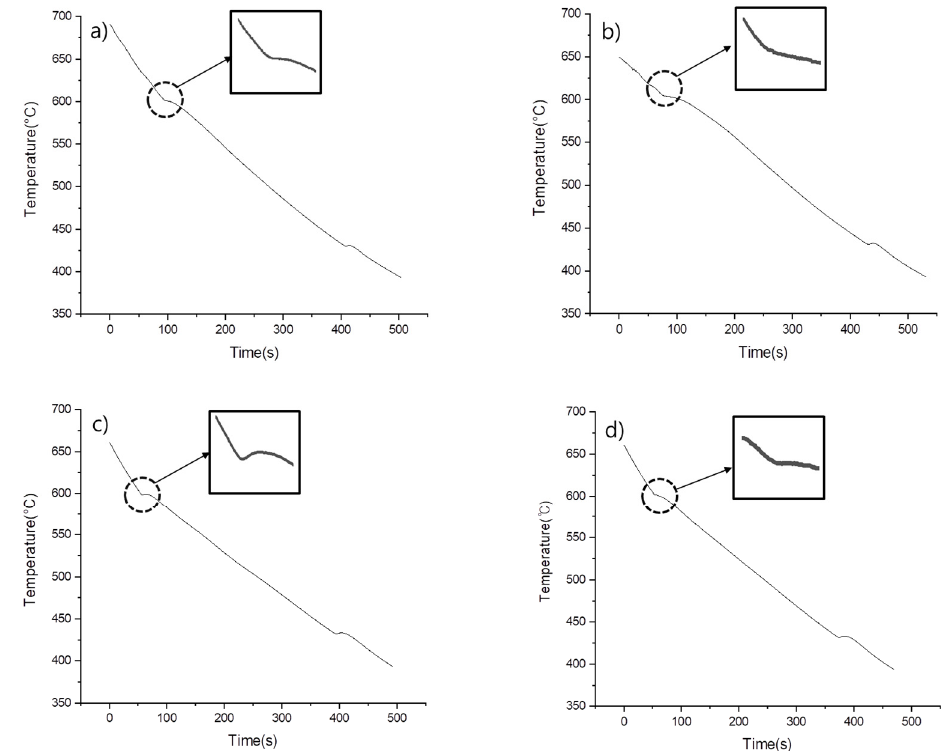
Figure 5. The cooling curves of ( a ) HP AZ91 before superheating, ( b ) HP AZ91 after superheating, ( c ) CP AZ91 before superheating, and ( d ) CP AZ91 after superheating. A vacuum-filtering experiment was performed to observe the particles affecting the grain refinement of CP AZ91 alloys by superheating. For HP AZ91 alloys, this experiment was not performed because grain refinement by superheating was not observed. As men-